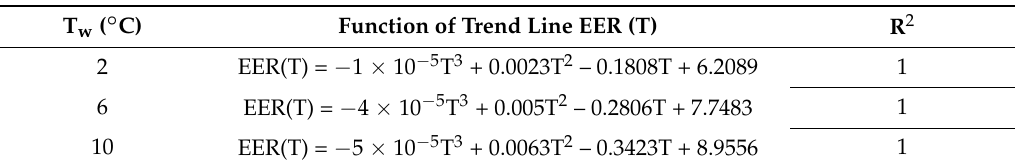
Table 3. Equations of the EER as functions of the Air Temperature T (T Aext or T Aout ) and the Water treated Temperature (T w ) at the maximum